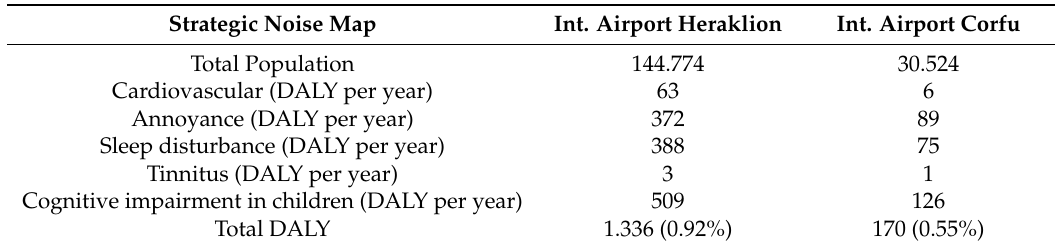
Table 3. Main results for the health burden of disease due to long-term exposure noise from